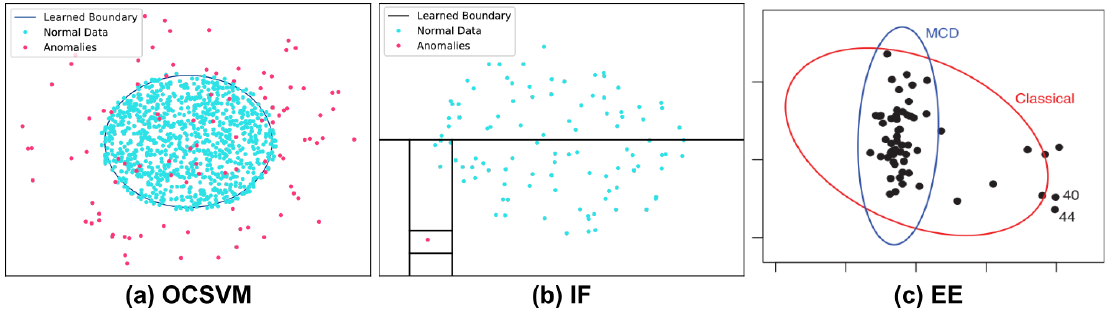
Figure 1. Examples of the models discussed in the literature review. Figure ( c ) taken from [22], Wiley Interdisciplinary Reviews: Computational Statistics